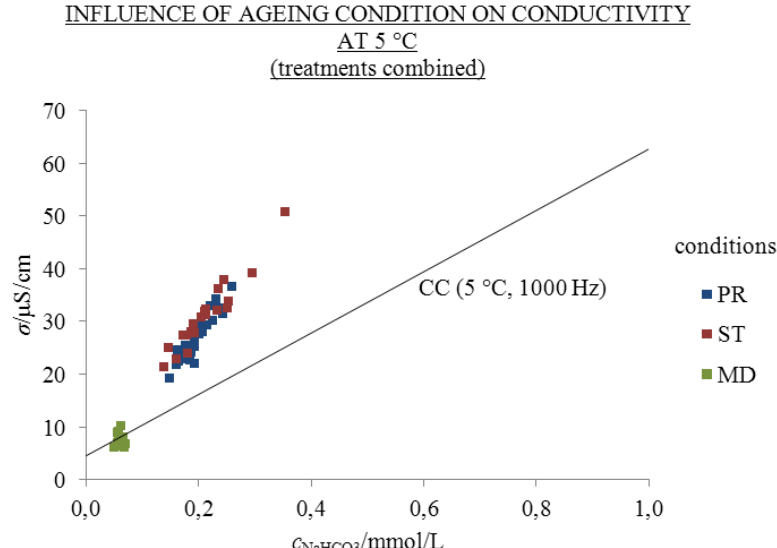
Figure 7. σ at 5 °C and 1000 Hz as a function of c 310 days in 2 mL volume of 2.5 mL flasks under conditions PR (blue), ST (red) and MD (green) aged solutions; points in the graph represent individual measurements; number of replicate solutions, N (/): PR (28), ST (20), MD (20). Treatments are combined; conductivity above the CC line is excess.